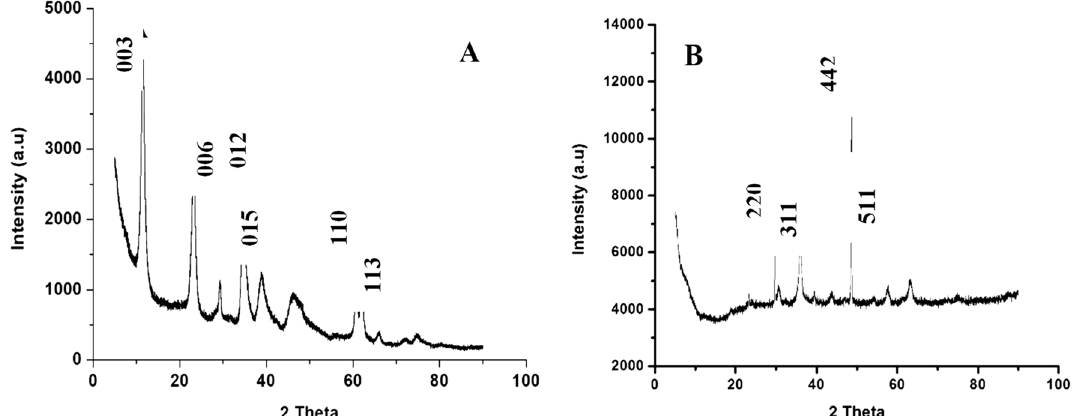
Figure 1. X-ray diffraction patterns of ( a ) magnetic Fe 3 O 4 /MgAl LDH nanocomposite, ( b )